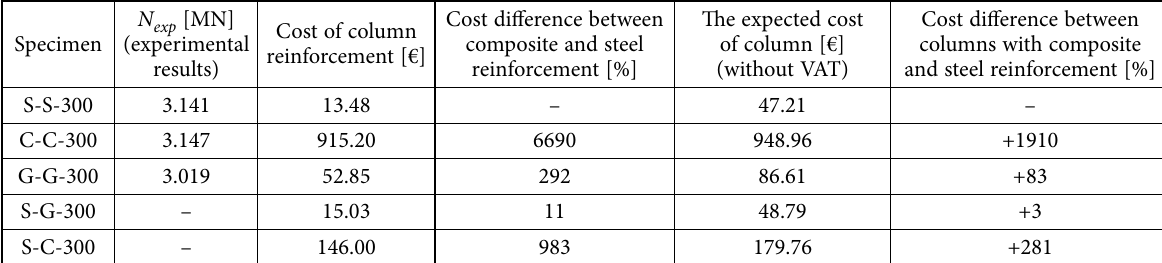
Table 4. The cost of columns with steel and composite reinforcement Specimen